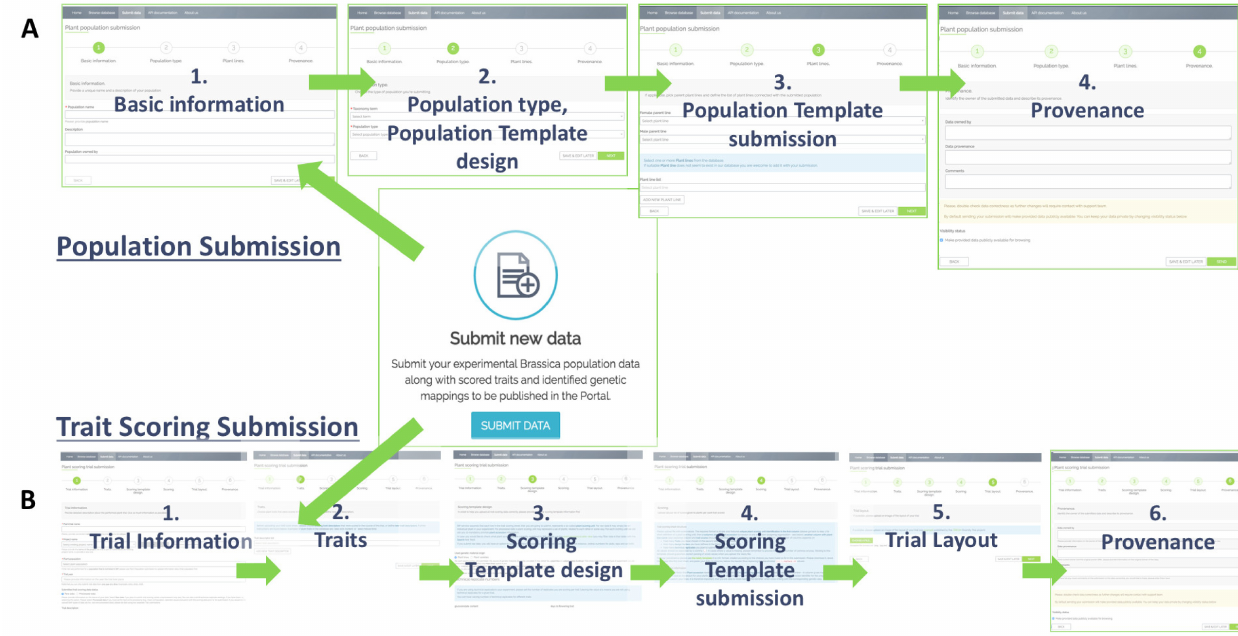
Figure 5. Wizards for Population Submission A ) and Trait Scoring Submission B ) comprise number of steps collecting required meta-data, to generate customised templates for data collection and to finally submit complete data